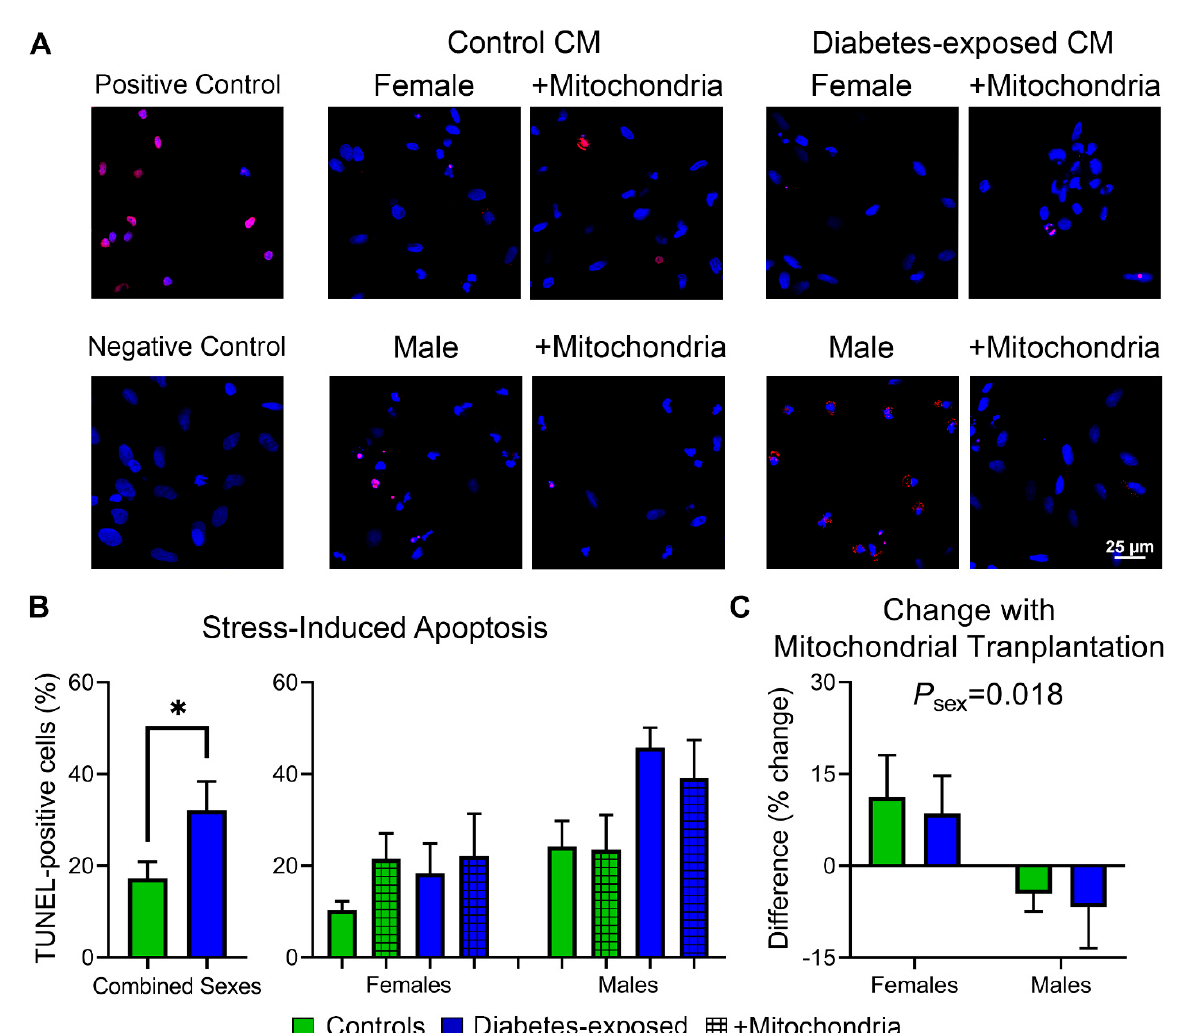
Figure 6. PGDM-exposed cardiomyocytes of both sexes are at greater risk of stress-induced apoptosis; mitochondrial transfer lowers this risk in males but worsens it in females. ( A ) Representative CM labeled with 4 (cid:48) ,6-diamidino-2-phenylindole (DAPI) and transferase dUTP nick end labeling (TUNEL) for apoptotic cell death following FCCP Challenge. DNase treatment was used as a positive control. TUNEL reaction without enzyme was used as a negative control. ( B ) Percentage of TUNEL-positive cells following FCCP Challenge. Males have higher numbers of TUNEL-positive cells regardless of group ( P = 0.005 by 1-way ANOVA; not demarcated). ( C ) Difference in TUNEL-positive cells with mitochondrial transfer. N = 4–5 per sex per group using 138 ± 10 cells per plate from 7–10 systematically imaged fields. Data represent mean ± SEM. * P ≤ 0.05 by 1-way ANOVA.